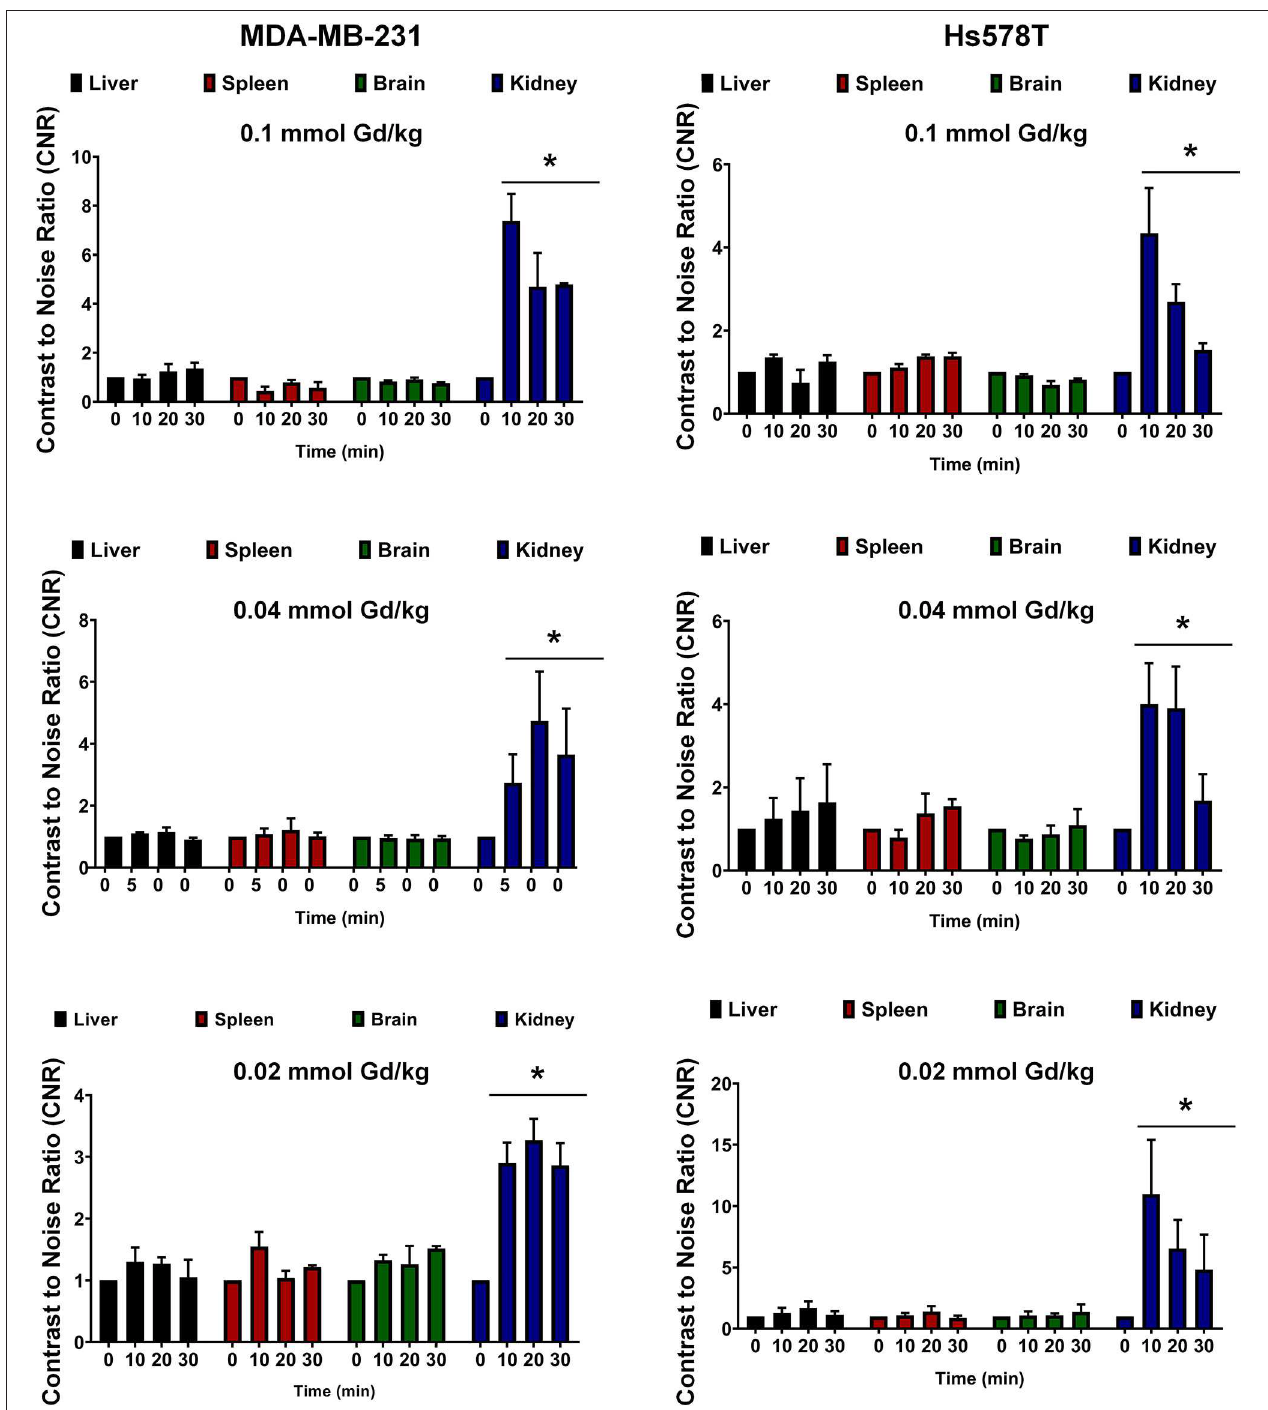
FIGURE 6 | Contrast-to-noise ratio at 10, 20, and 30min post-injection of MT218 at doses of 0.1, 0.04, and 0.02 mmol Gd/kg. Analysis of fold increase of CNR of liver, spleen, brain, and kidney were acquired in groups as indicated. Post-contrast CNRs of kidneys are significantly increased over pre-contrast (* p < 0.05).